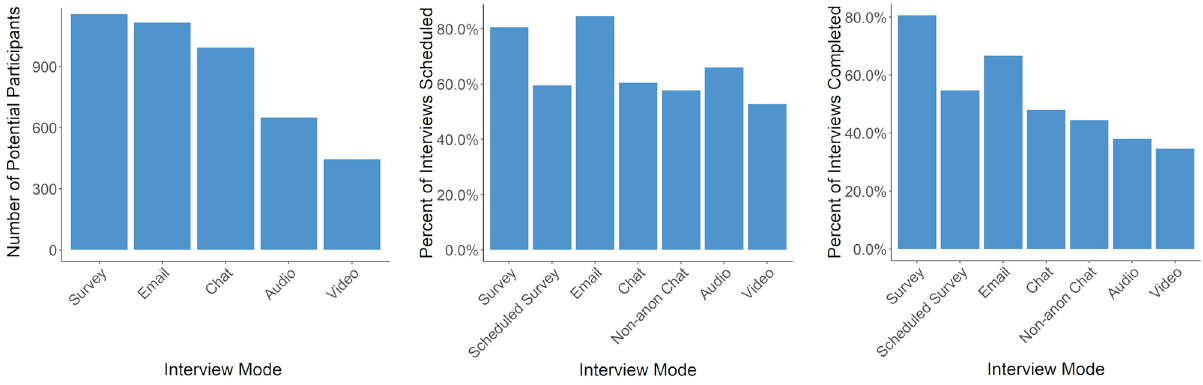
Fig 1. Differences in recruitment and logistics across mode. (A) Differences in willingness to participate across interview mode ( n = 1240). (B) Differences in the scheduling rate, comparing those who scheduled an interview ( n = 200) to those who were invited ( n = 310), across mode. (C) Differences in completion rate, comparing those who scheduled an interview ( n = 154) to those who were invited ( n = 310), across mode.